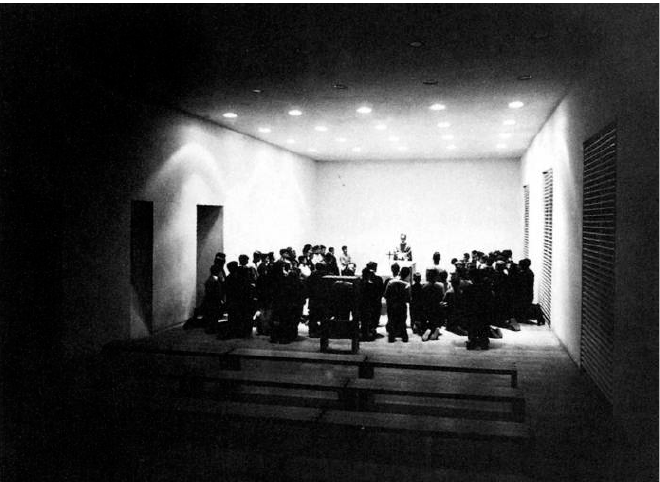
Figure 6. Student chapel, Abbey of Melk (AT) 1966, design by Ottokar Uhl: intimate gathering for the Eucharist around a large table as part of a spatial choreography for the liturgy (photograph by Gert Schlegel, the authors of the article have made any possible attempt to locate and contact the owner of the copyright of this figure).